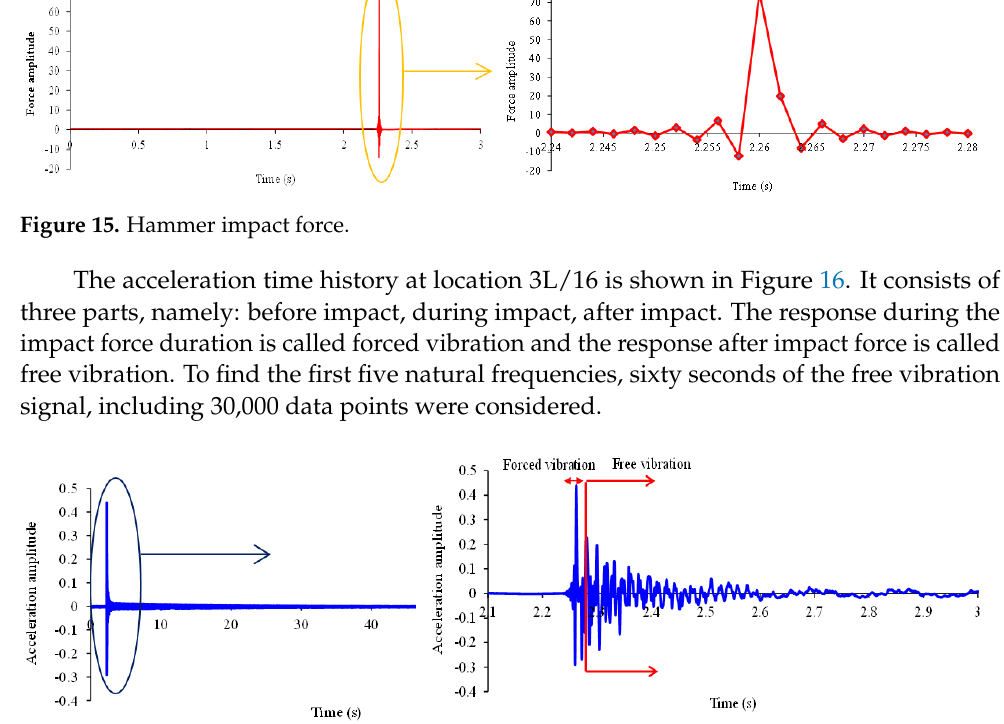
Figure 16. Acceleration response at location 3L/16.